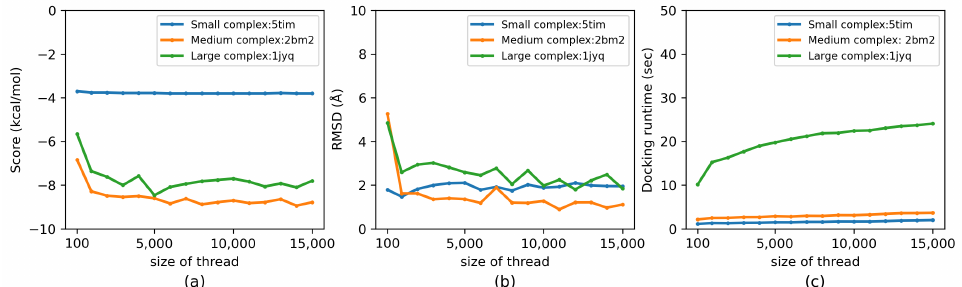
Figure 3. Influence of the size of thread on docking accuracy (score and RMSD) and docking runtime of Vina-GPU in ( a ), ( b ) and ( c ), respectively. Three typical PDB complexes are randomly selected from all 140 complexes which represent small, medium and large ones, respectively (5tim—small, 5 atoms; 2bm2—medium, 33 atoms; 1jyq—large, 60 atoms). All experiments were executed on NVIDIA RTX 3090 GPU card.